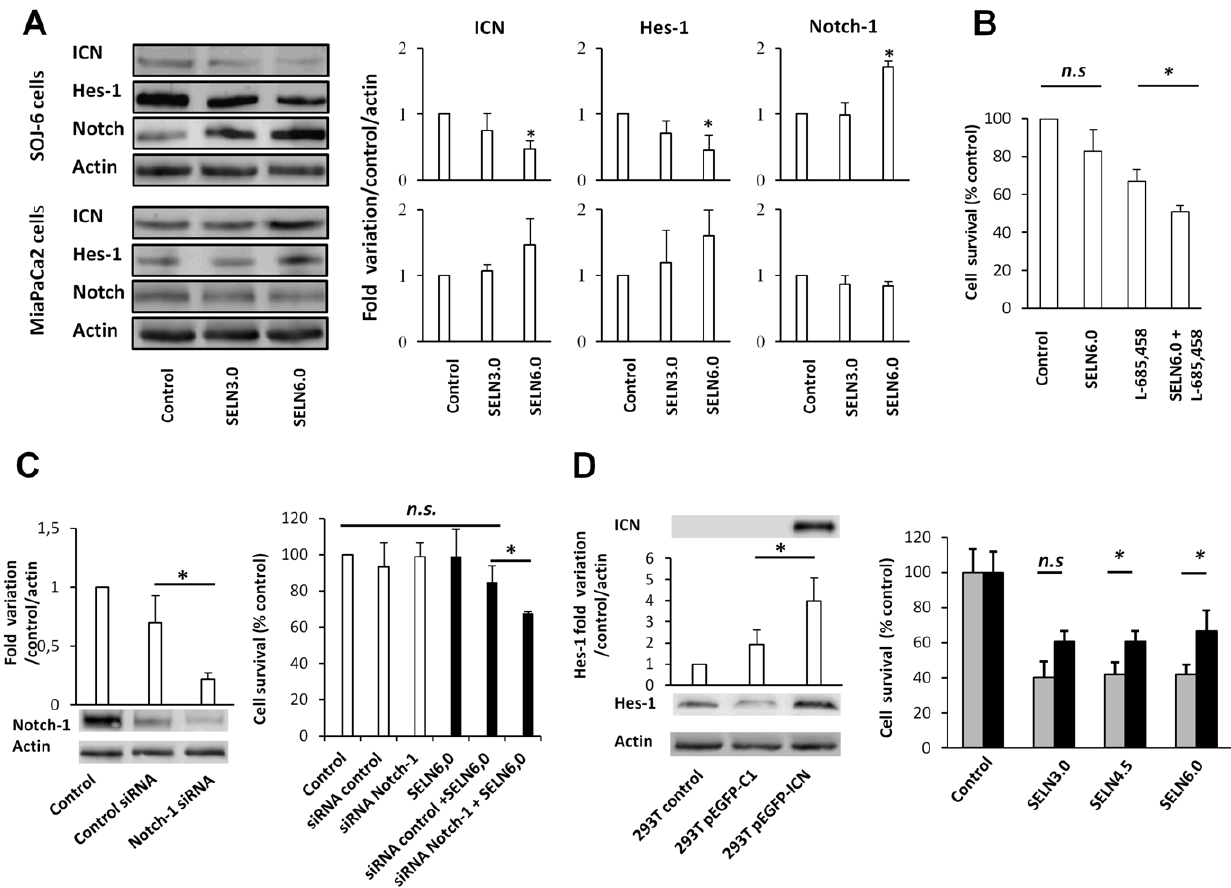
Figure 3. Effect of SELN on Notch pathway. (A) SOJ-6 and MiaPaCa-2 cells were starved then treated for 24 h with SELN (16 nmoles cholesterol/ ml) and lysed. Cell lysate proteins were separated on SDS-PAGE (80 m g of proteins/lane) and electrotransferred onto nitrocellulose membrane. The levels of ICN, Hes-1, Notch-1 and b -actin were determined by probing membranes with specific antibodies as indicated. Western blots are representative of three independent experiments. Lane 1, control performed in the absence of SELN, Lane 2, in the presence of SELN 3.0, Lane 3, in the presence of SELN 6.0. The right panels in figure 3A represents the quantification of western blots (means ( 6 SD) of three independent experiments) using the NIH Image program (Mann-Whitney test). (B) MiaPaCa-2 cells were incubated with medium (control), with L-685,458 c - secretase inhibitor (GSI, 2.5 m M), with SELN6.0 (16 nmoles of cholesterol/ml), with SELN6.0 and GSI. The L-685,458 GSI was added 60 min before freshly prepared SELN6.0. Cells were further incubated for 24 h in the presence of each component and cell proliferation was determined. Results are means ( 6 SD) of independent experiments (n=36, Student’s t -test). (C) MiaPaCa2 cells were transfected with a mix of Notch-1 siRNA or with a control siRNA. In the left panel cell lysate proteins (50 m g of proteins) of parental, control and Notch-1 siRNA transfected MiaPaCa-2 cells were separated on SDS-PAGE and analyzed by western blotting (72 h post-transfection). The histogram indicates quantification of western blots. In the right panel cell survival of parental and transfected MiaPaCa-2 cells was assessed through a MTT test after 24 hours of incubation with (black columns) or without (white columns) SELN6.0. The proliferation of MiaPaCa-2 cells recorded in the absence of SELN was taken as 100%. Results are means ( 6 SD) of three independent experiments (Mann-Whitney test). (D, left panel) HEK 293 T cells were transiently transfected with the pEGFP-C1 control plasmid or pEGFP-ICN plasmid encoding ICN (Notch-1 intracellular domain). Cell lysate proteins of parental and transfected HEK 293T cells were separated on SDS-PAGE and analyzed by western blotting using primary antibodies as indicated. Western blotting replicates depicted the expression level of ICN and the nuclear target of ICN, Hes-1, in parental (293T control), pEGFP-C1 control vector-transfected (293TpEGFP-C1) and pEGFP-ICN-transfected (293TpEGFP-ICN) HEK 293T cells. The amount of loaded proteins was the same (50 m g) for each lane as indicated by b -actin probing. The histogram displays the quantification of Hes-1 as determined from western blots. (D, right panel) HEK 293TpEGFP-C1-transfected cells (grey columns) and HEK 293TpEGFP-ICN-transfected cells (black columns) were challenged without (control) or with SELN3.0, SELN4.5 and SELN6.0 (16 nmoles cholesterol/ml) for 24 h. Cell survival was determined with MTT. The proliferation of HEK 293T cells transfected with the control vector (293TpEGFP-C1) recorded in the absence of SELN was taken as 100%. Values are means 6 SD of three independent experiments (Mann-Whitney